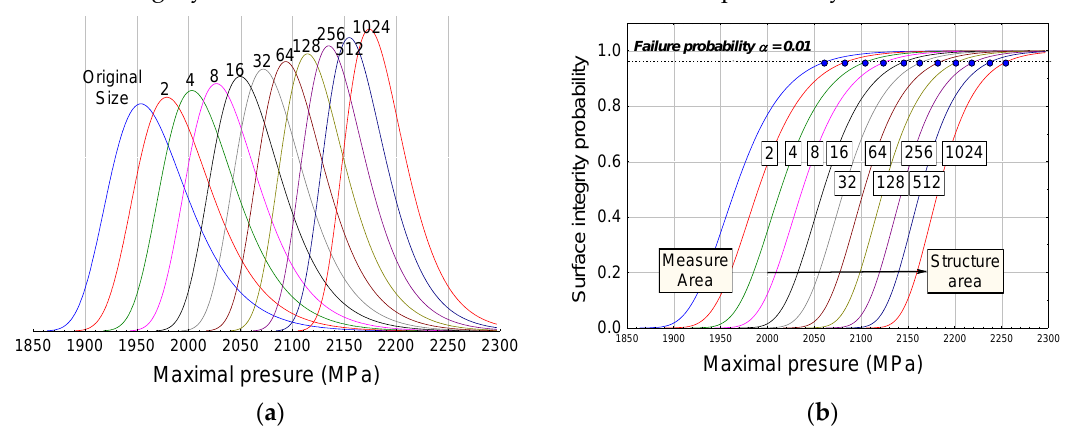
Figure A1. ( a ) Multi-scale Probabilities Function of Surface integrity versus Surface Area; ( b ) Probability of failure versus the size area at a probability.